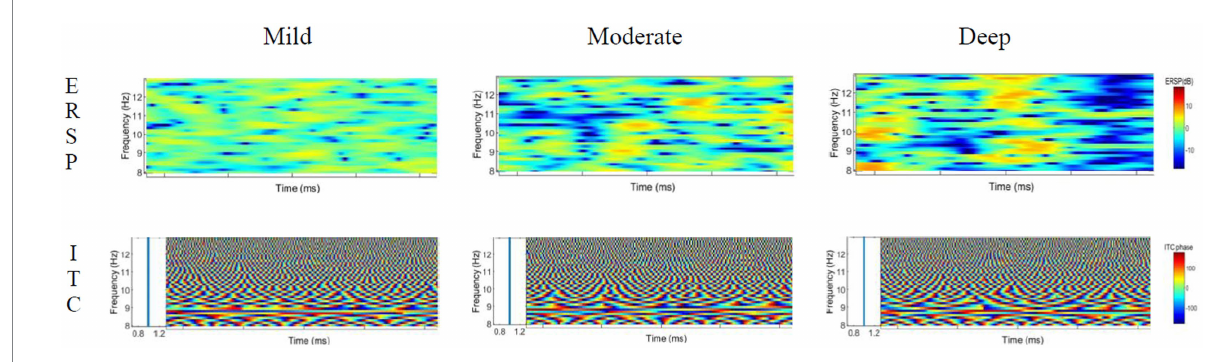
FIGURE 11 ERSP and ITC characteristics of the alpha wave under different cognitive workload